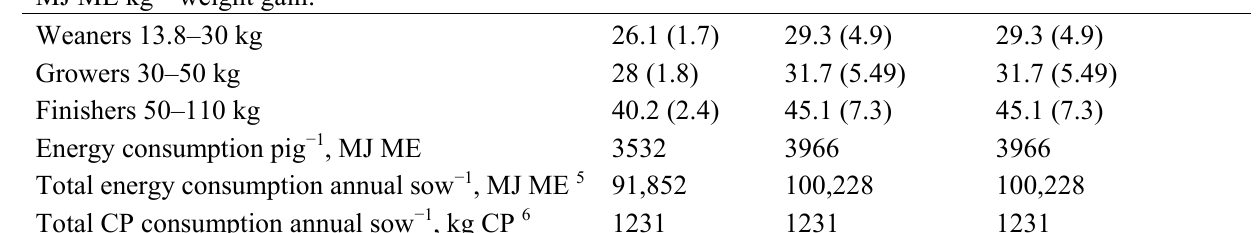
Free-Range: Alternative Crops